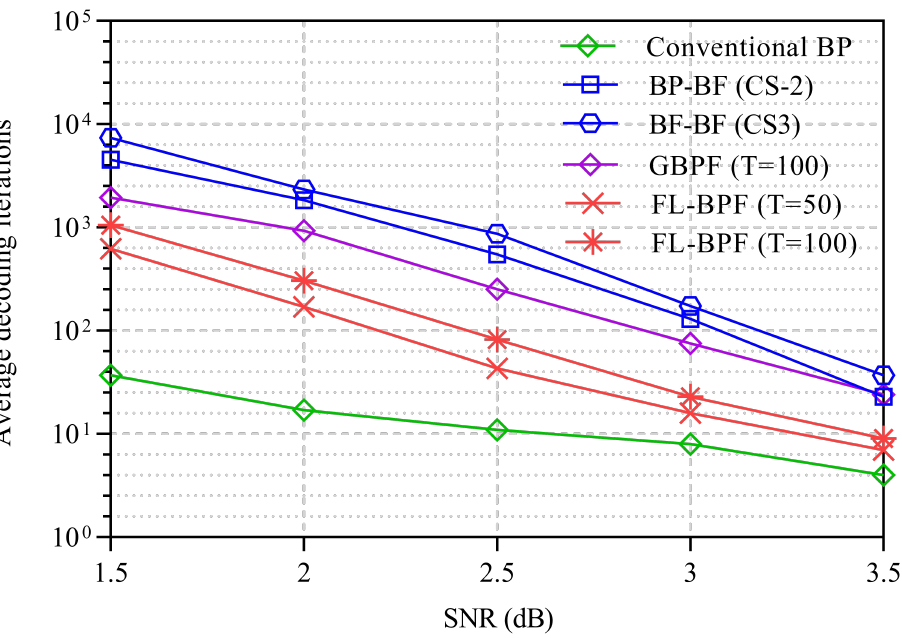
Figure 6. Average decoding iterations concerning BP, BP-BF, generalized BP flip, and FL-BP for P ( 256,128 ) with I max =100. Table 4. Comparison of decoding clock cycles with respect to the FL-BP, BP-BF, and GBPF techniques under different SNRs for P ( 256,128 + 24 )